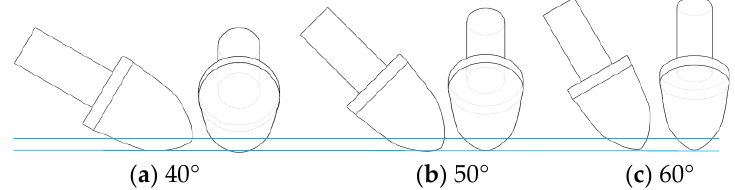
Figure 11. The relationship between cutting angle and rock cutting area.